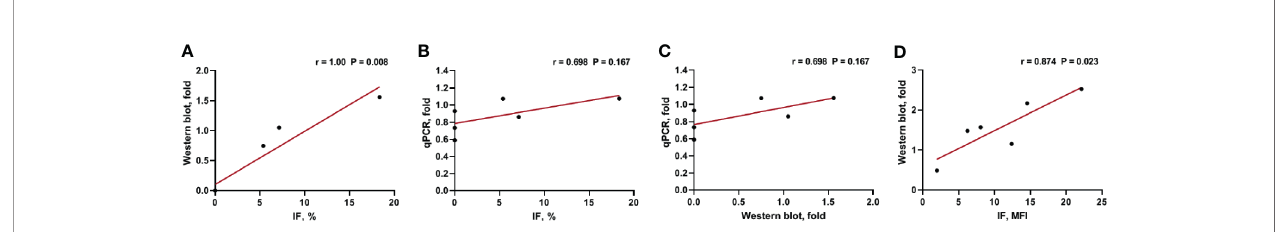
FIGURE 3 | Correlation between Gal-9 and PD-L1 expression results using different detection methods. (A) Western blotting vs. IF, (B) qPCR vs. IF, (C) qPCR vs. western blotting in Gal-9 analysis, and (D) Western blotting vs. IF in PD-L1 analysis. IF, immuno fl uorescence; qPCR, quantitative